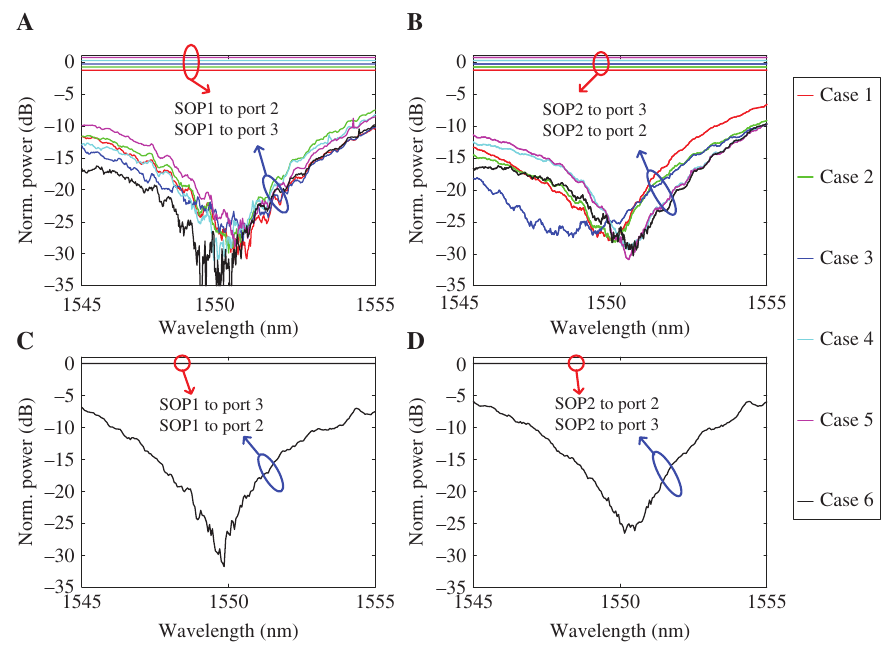
Figure 4: Transmission spectra for polarization MIMO descrambler and polarization switch. Six random states are tested. (A, B) Routing state: SOP 1–Port 2, SOP 2–Port 3. (C, D) Routing state: SOP 1–Port 3, SOP 2–Port